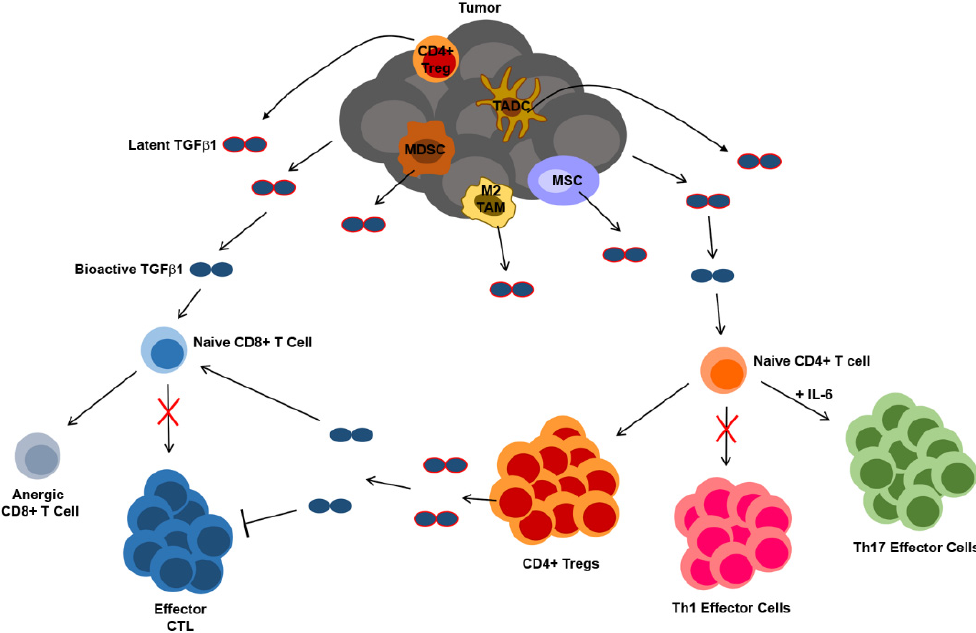
Figure 4. Summary of the mechanisms by which TGF β 1 derived from tumors and tumor-associated cells may influence the differentiation and function of CD4+ and CD8+ T lymphocytes. TADC = tumor-associated dendritic cell, TAM = tumor-associated macrophage, MSC = mesenchymal stem cell, MDSC = myeloid-derived suppressor cells, CTL = cytotoxic T lymphocyte, Treg = regulatory T cell.